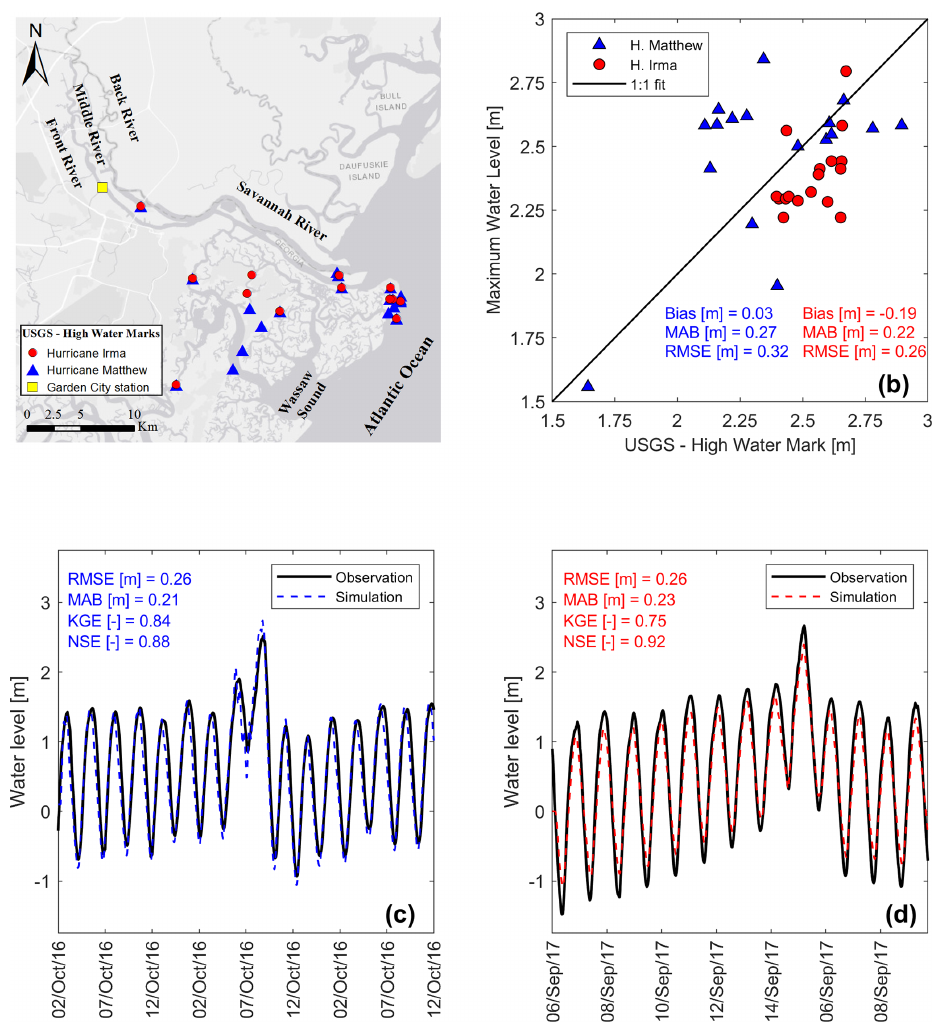
Figure 4. Calibration and validation of the Savannah Delft3D FM model. (a) Location of high-water marks (HWMs) in the Savannah River delta for Hurricane Matthew (blue triangles) and Hurricane Irma (red circles). (b) Comparison between simulated maximum water levels (WLs) and HWMs in the Savannah. (c, d) Time series of simulated and observed WLs at the Garden City station for Hurricane Matthew and Hurricane Irma,